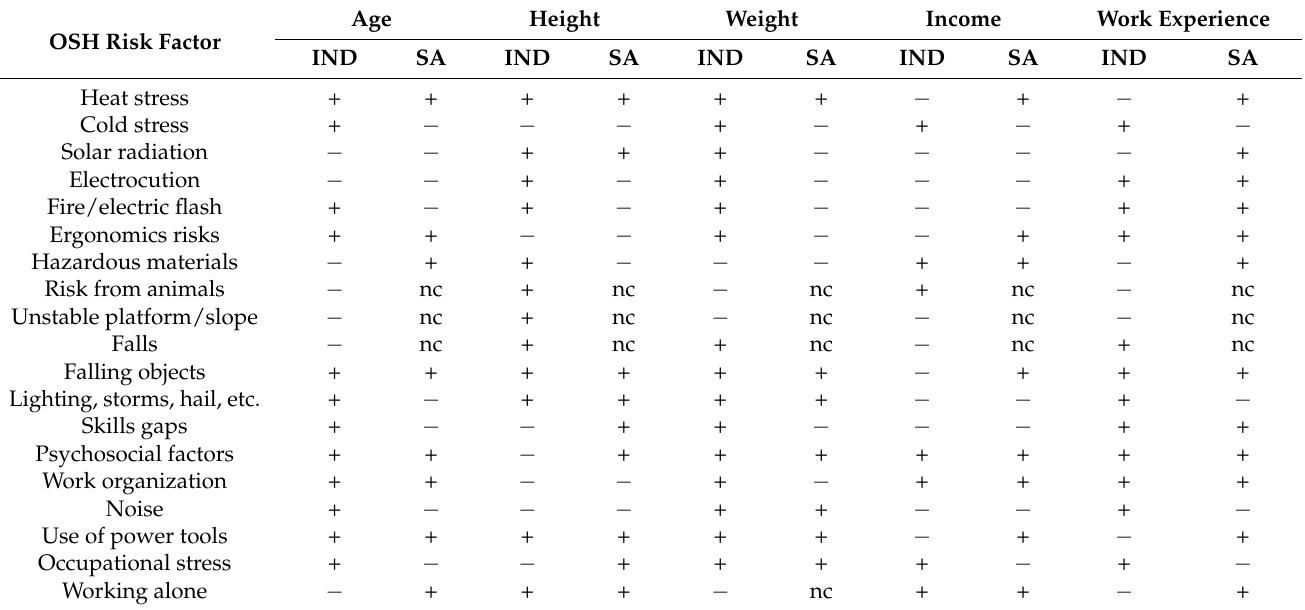
Table 4. Correlation between OSH risks and socio-demographic factors for solar PV workers in two countries. Sample size is 53 for Indian workers and 82 for workers in Saudi Arabia, totaling 135 workers. (+ indicates positive correlation, while − indicates negative correlation).